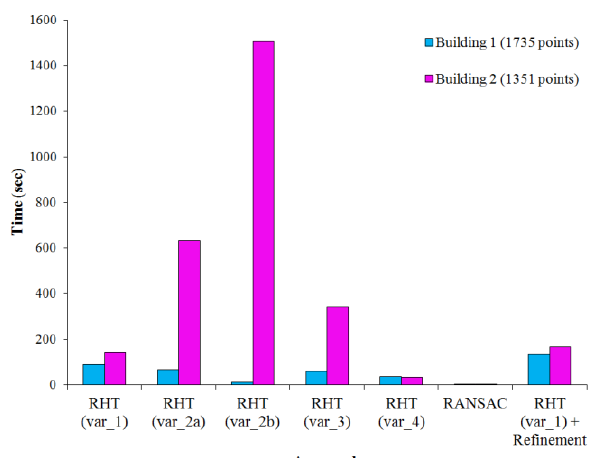
Figure 6. The computational time of each variation of the RHT and RANSAC applied at Buildings 1 and